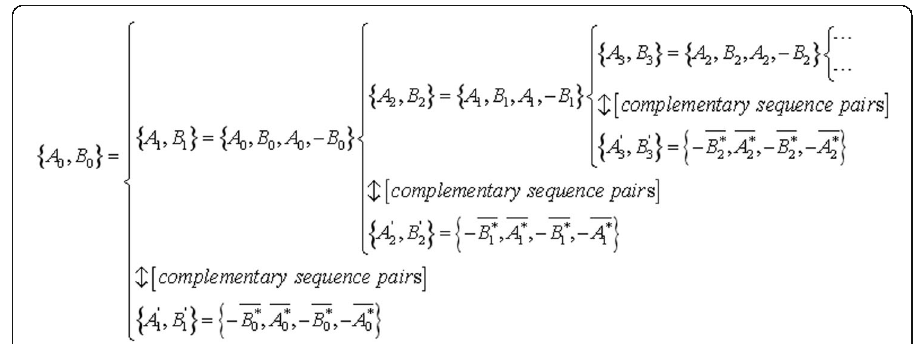
Fig. 4 Recursive construction algorithm flow chart. A recursive algorithm for constructing complete complementary